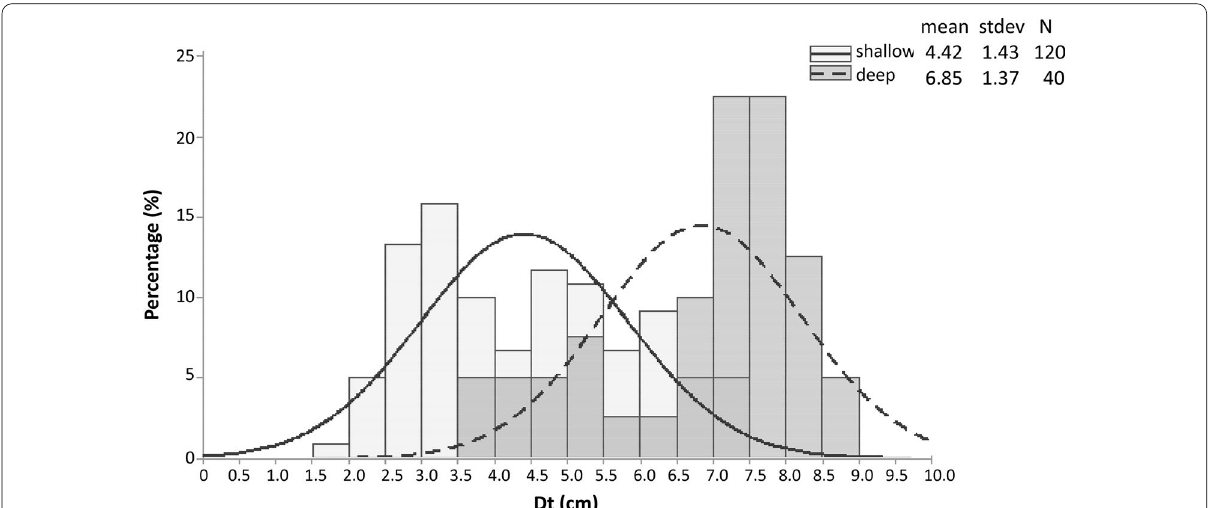
Fig. 5 Size (Dt test diameter)—frequency distribution of the studied Diadema setosum population per depth distribution zones surveyed (data = were pooled over stations and